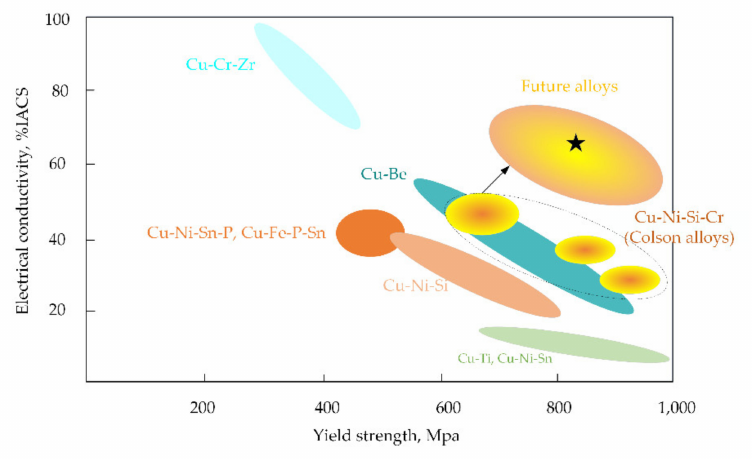
Figure 4. Conventional High-Spec and new copper alloys.